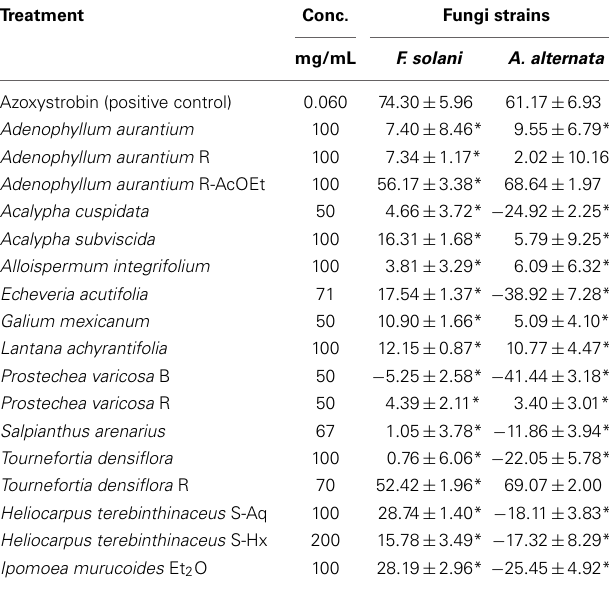
Table 2 | Percent of inhibitory activity on mycelial radial growth of F. solani and A. alternata produced by crude plant